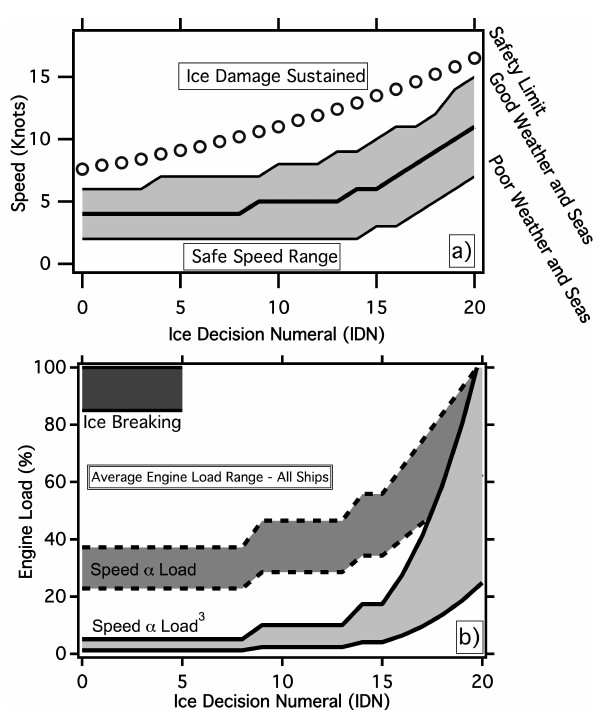
Fig. 5. (a) Ice Decision Numeral relationship to safe ship speeds in the Arctic. Reproduced from the data from Table 6 of McCal- lum (1996). Shaded area is standard deviation of data from multiple ships and different ship classes. (b) The estimated engine load char- acteristics of all ship types currently operating in the Arctic, as a function of IDN. Average speed/IDN and high speed/IDN relation- ship